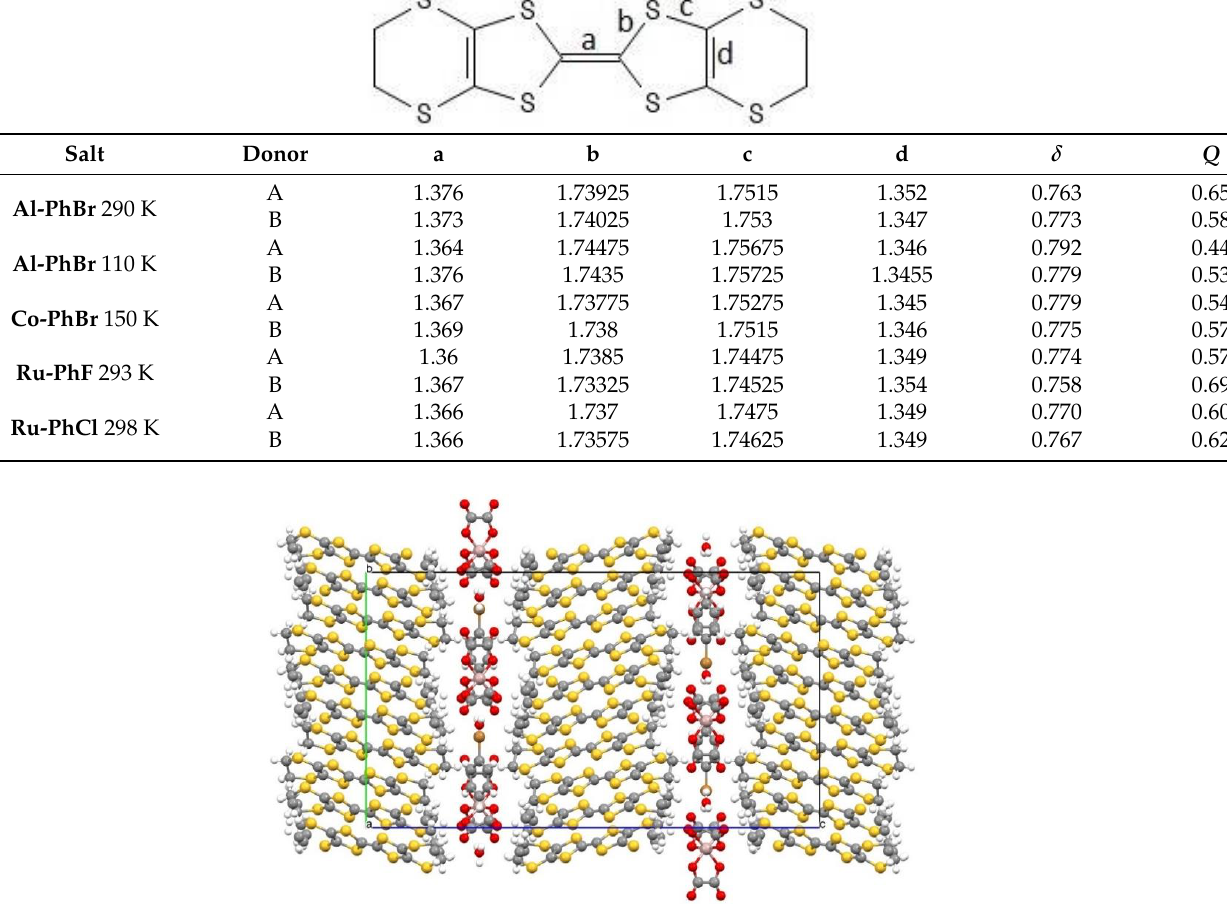
Table 3. Average bond lengths (Å) in BEDT-TTF molecules with approximation of the charge on the molecules. δ = (b + c) − (a + d), Q = 6.347 − 7.463 δ [50].